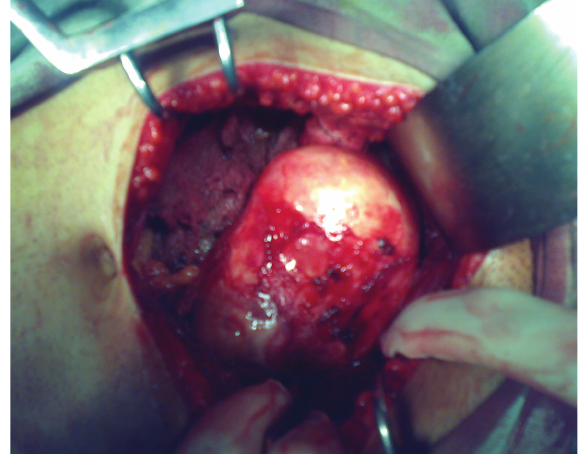
Figure 2: Intraoperative picture of a pelvic hydatid after complete mobilization.